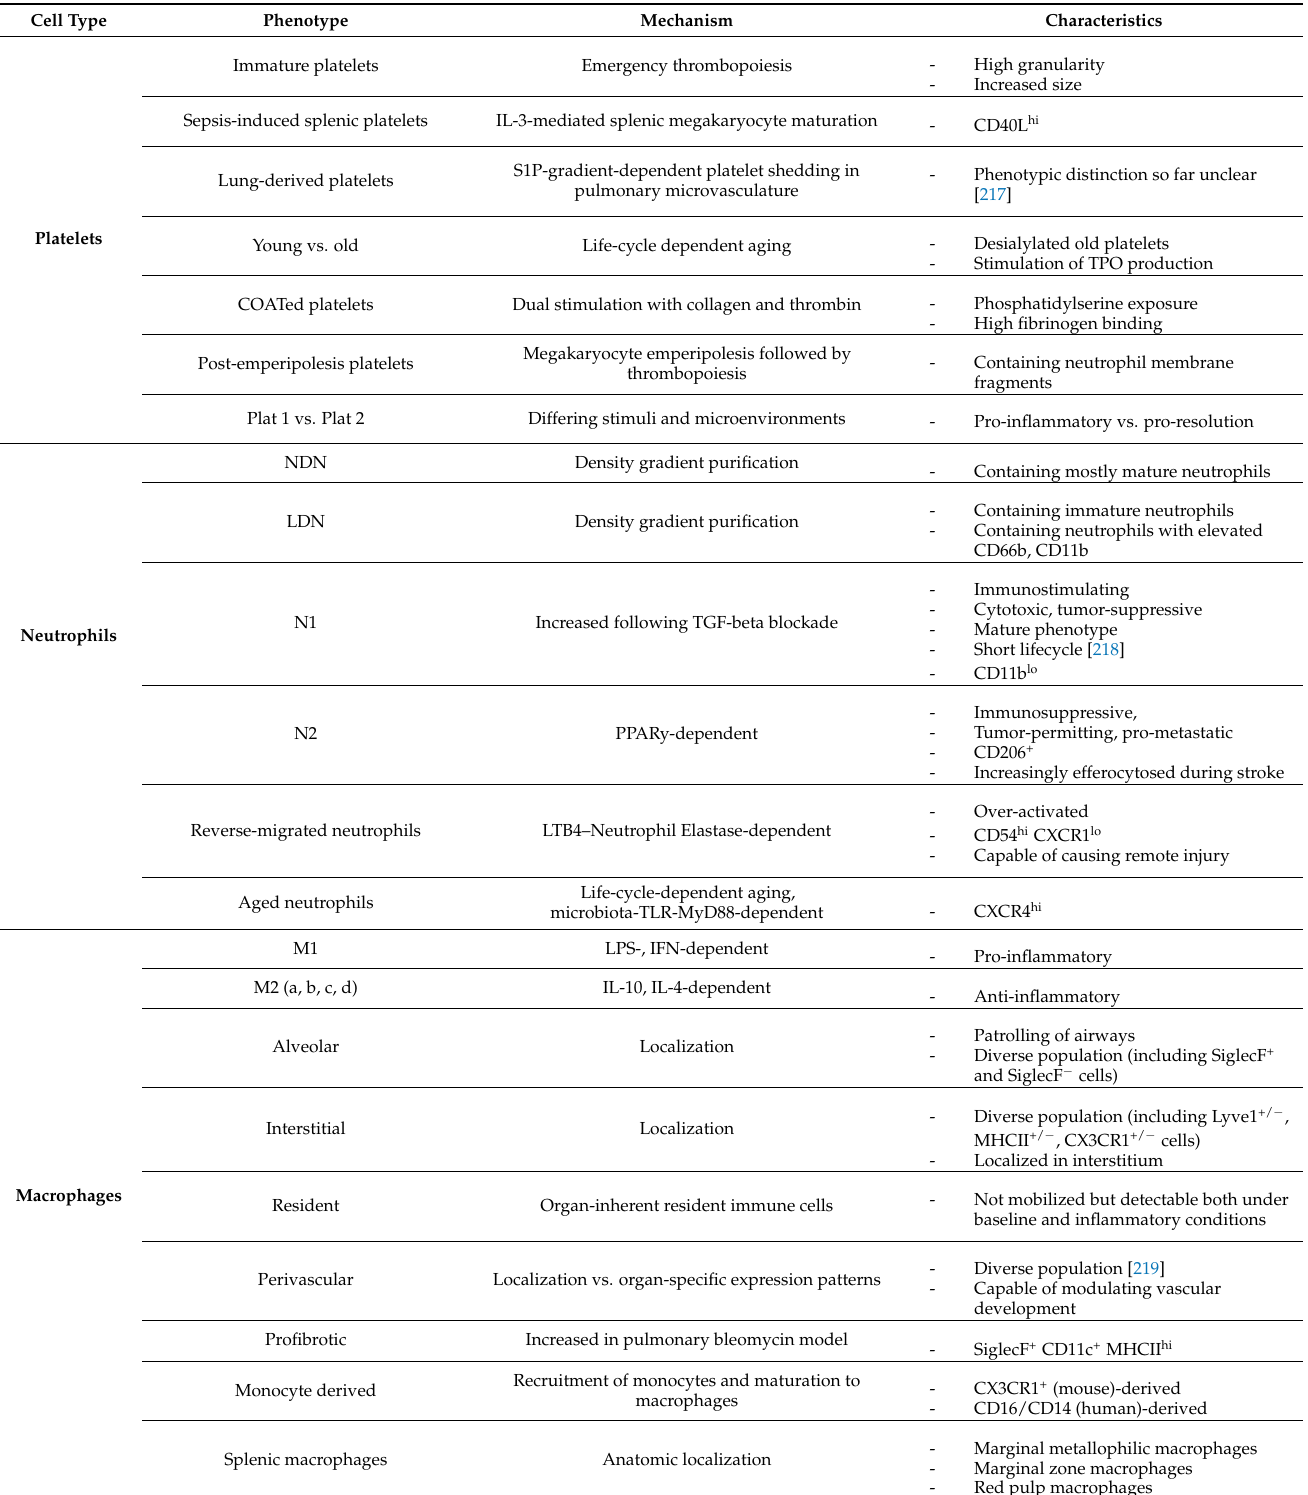
Table 2. Commonly ascribed immune cell